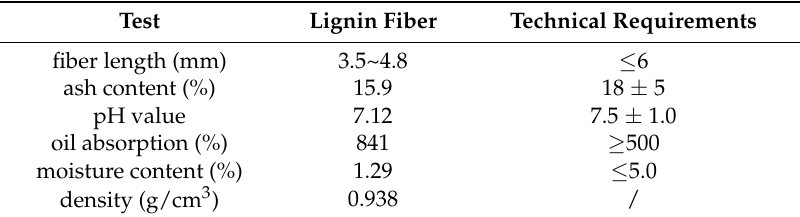
Table 2. Properties of